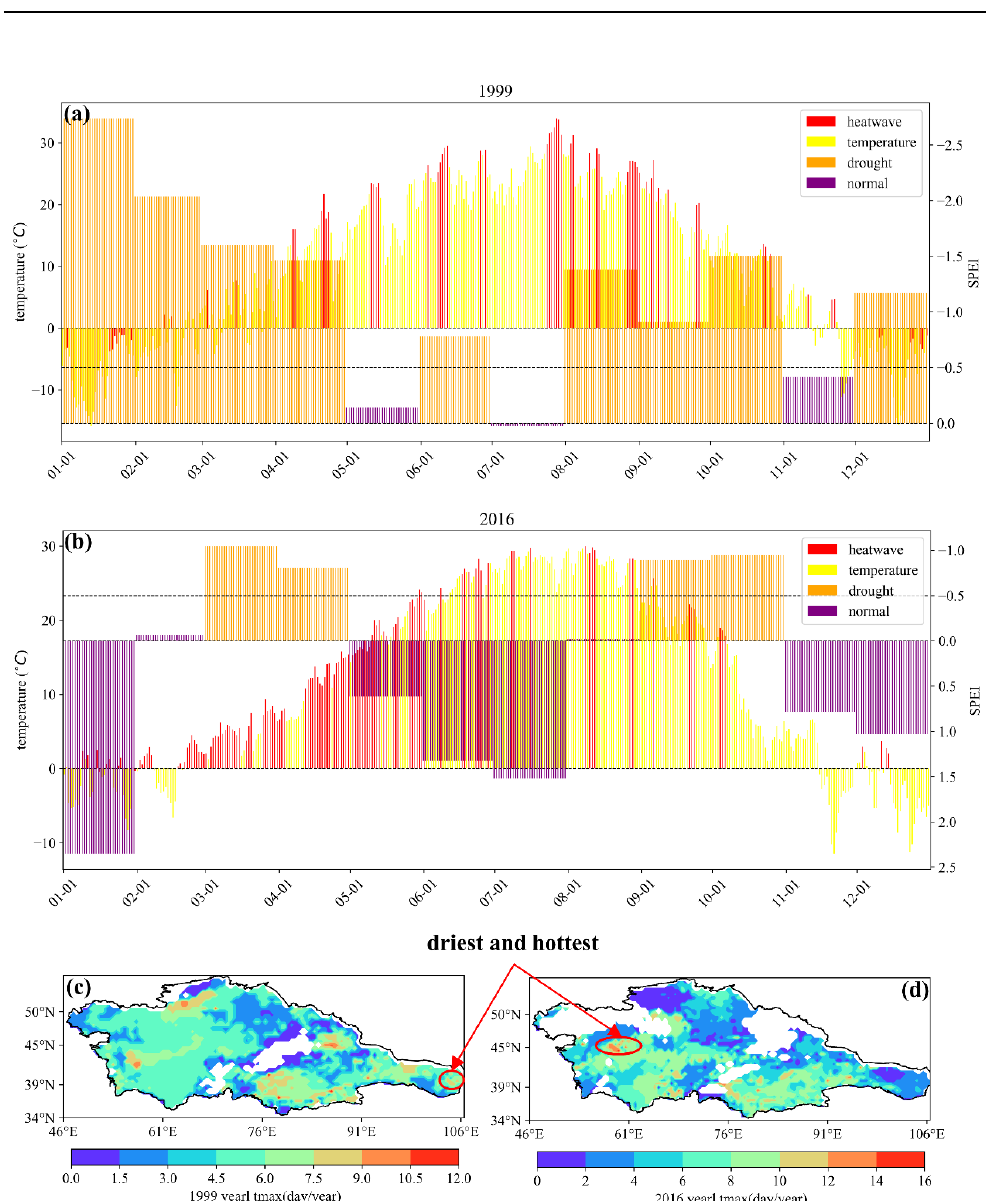
Figure 9. Discussion on the relationship between CDHWs, drought events, and heatwave events. ( a ) Statistics regarding the hottest and driest grid points in the base period (1999); ( b ) statistics regarding the hottest and driest grid points in the reference period (2019); ( c , d ) driest points in the base and reference periods, respectively, and the spatial distribution of the hottest grid points.